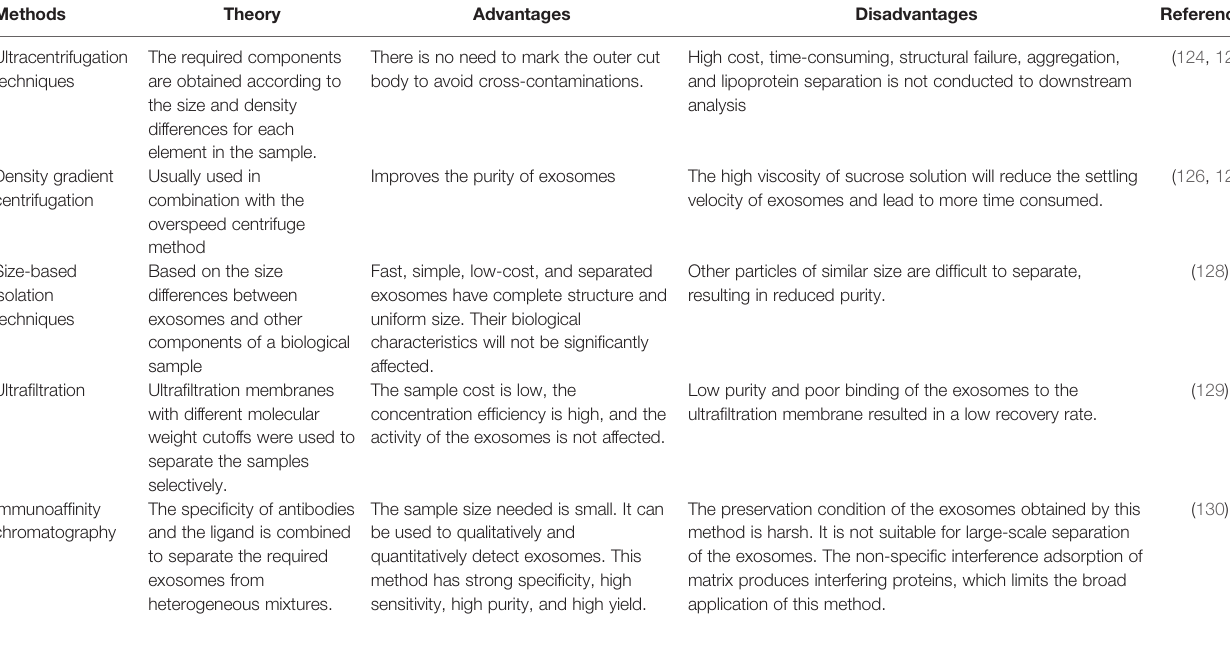
TABLE 5 | Exosome ’ s isolation methods, advantages, and